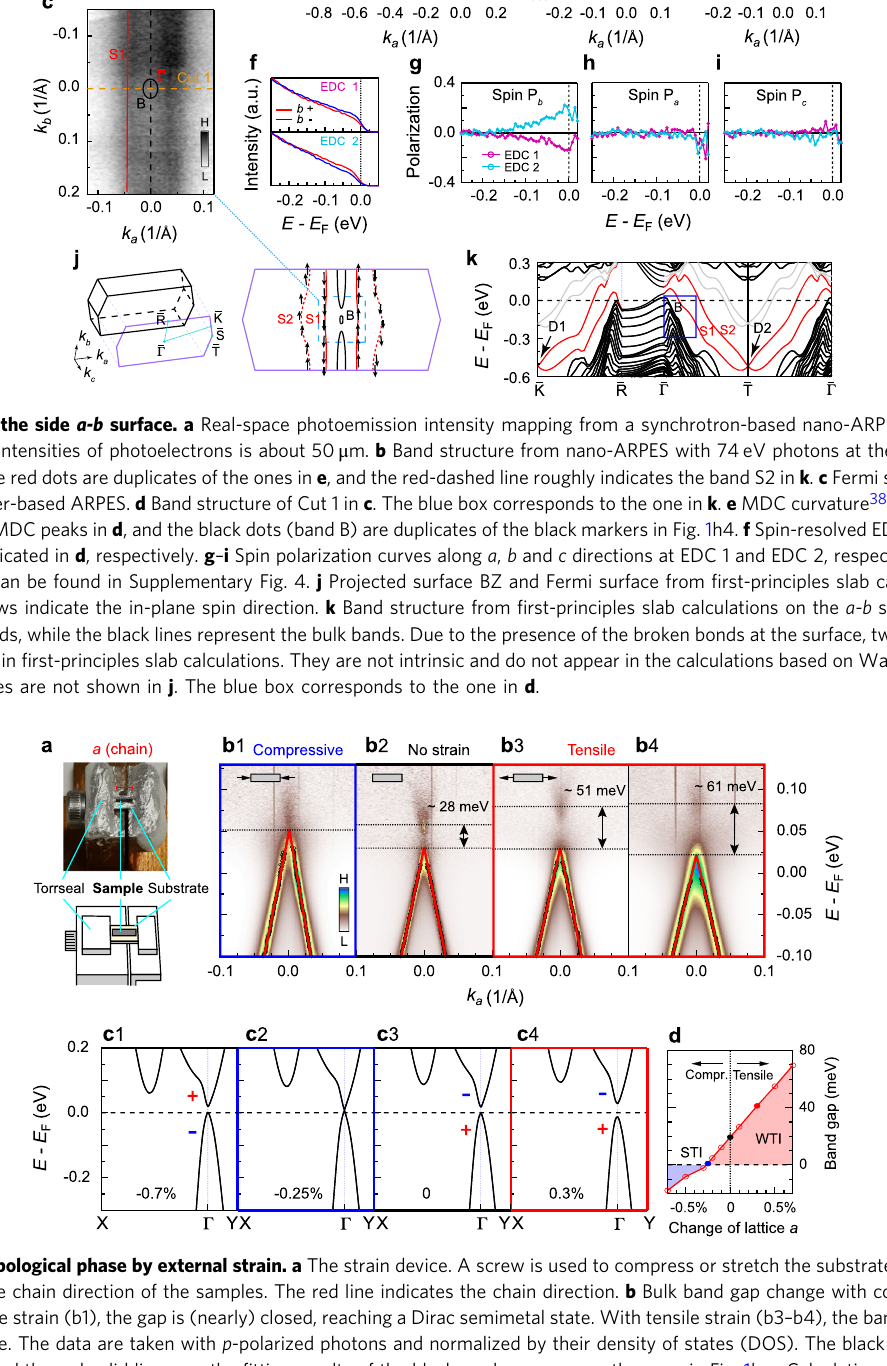
NATURE COMMUNICATIONS| (2021) 12:406